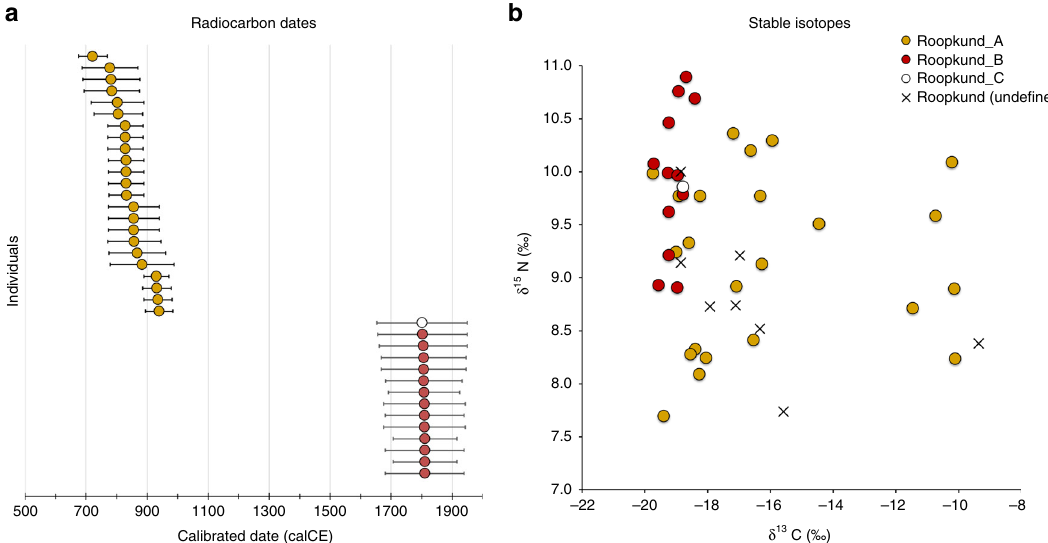
Fig. 3 Radiocarbon and Isotopic Evidence of Distinct Origins of Roopkund Genetic Groups. a We generated 37 accelerator mass spectrometry radiocarbon dates and calibrated them using OxCal v4.3.2. The dating reveals that the individuals were deposited in at least two events ~1000 years apart. In fact, the Roopkund_A individuals (shown in yellow) may have been deposited over an extended period themselves, as the 95% con fi dence intervals for some of the radiocarbon dates (for example I6943 and I6941) do not overlap. Radiocarbon dates indicate that Roopkund_B (shown in red) and Roopkund_C (shown in white) individuals may have been deposited during a single event. Error bars indicate 95.4% con fi dence intervals. Calibration curves are shown in Supplementary Fig. 1. b We show normalized δ 13 C and δ 15 N values for samples with isotopic data: 37 for which genetic data were generated (circles with colors indicating their cluster), and eight for which no genetic data were generated (labeled Roopkund_U). In cases where multiple measurements were obtained, we plot the average of all measurements. The plotted data are provided as a Source Data fi